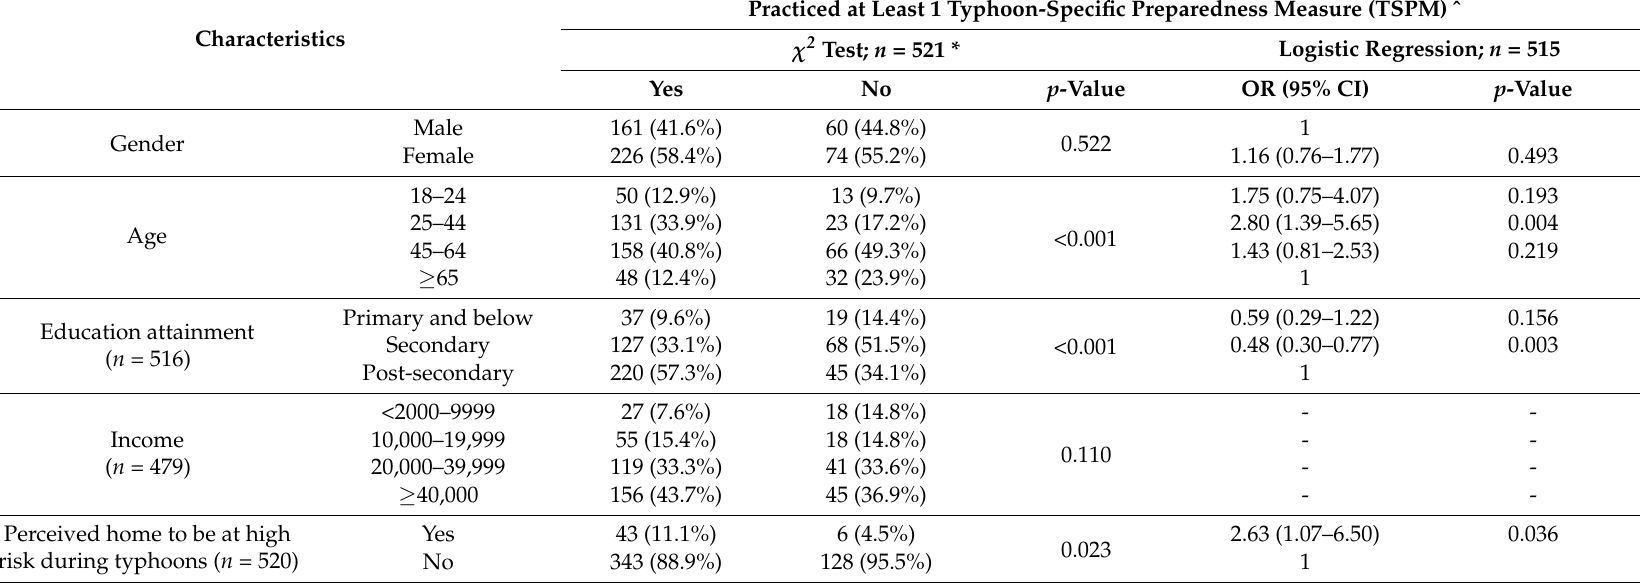
Table 3. The association of demographics with practiced typhoon-specific preparedness measures (TSPM) and risk perception.